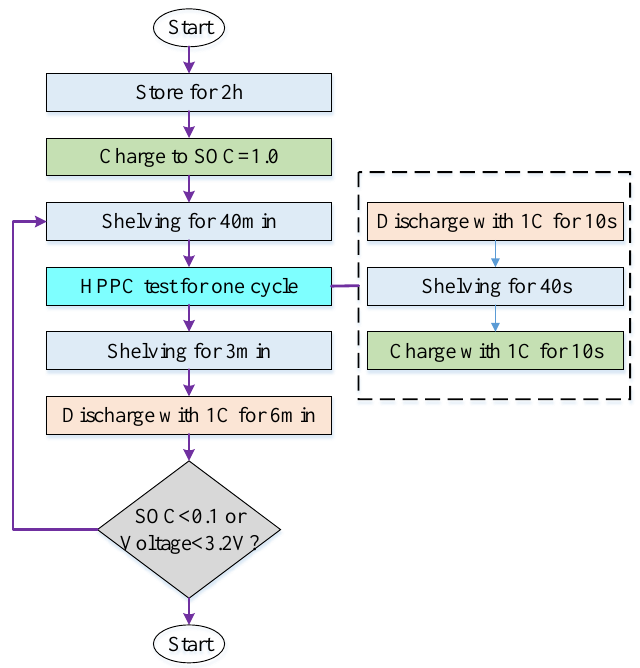
Figure 2. Experimental flow chart.